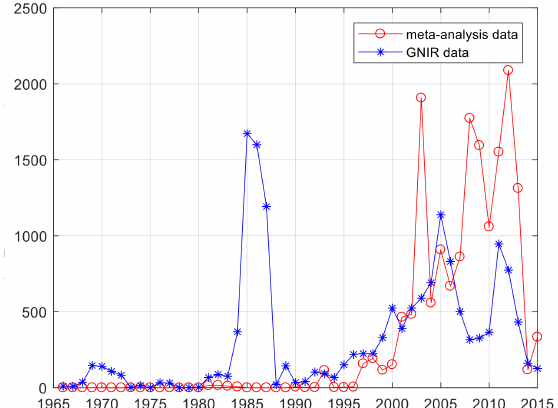
Figure 4. Time of GNIR data and meta-analysis data. Red circles and blue asterisks represent the amount of meta-analysis data and original GNIR data in the year,